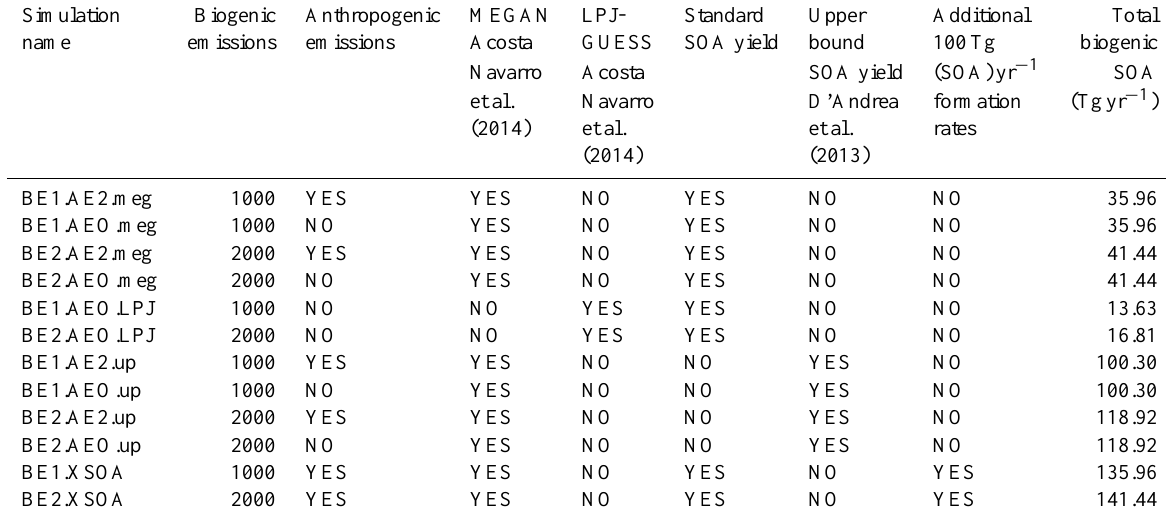
Table 1. Summary of the GEOS-Chem-TOMAS simulations performed in this study. Biogenic emissions for year 1000 and 2000 using MEGAN are decadal-averaged emissions for 1000–1010 and 1980–1990, respectively, whereas LPJ-GUESS biogenic emissions are annual- averaged for the years 1000 and 2000. Standard SOA yields are 3, 10, and 20% for isoprene, monoterpenes, and sesquiterpenes, respectively, and upper-bound SOA yields are 10, 20, and 40% for isoprene, monoterpenes, and sesquiterpenes, respectively. In the simulation naming scheme, “BE” refers to biogenic emissions, “1” refers to year 1000, “2” refers to year 2000, “O” refers to off, “meg” refers to MEGAN BVOC emissions, “LPJ” refers to LPJ-GUESS BVOC emissions, “up” refers to upper-bound SOA yields, and “XSOA” refers to the inclusion of the additional 100Tg(SOA)yr − 1 .